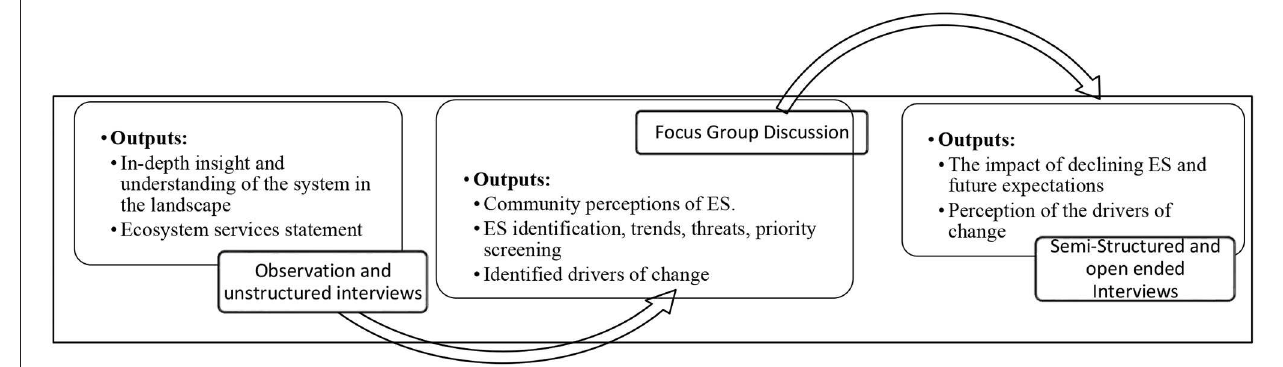
FIGURE 2 | Research